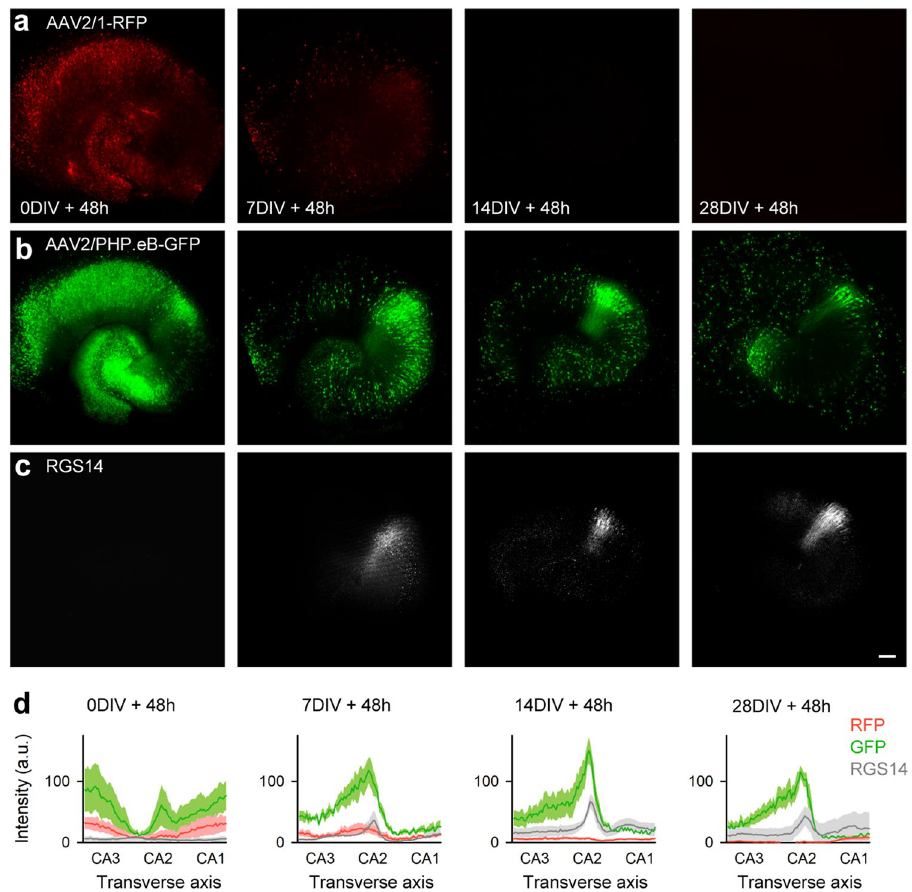
Figure 3. AAV2/PHP.eB vector preference for the CA2 region in ex vivo organotypic slice cultures. ( a ) RFP, ( b ) GFP, and ( c ) RGS14 protein distribution in hippocampal slice cultures. AAV2/1-SynTetOff-mRFP1 and AAV2/ PHP.eB-SynTetOff-EGFP were added to slice cultures at 0, 7, 14, and 28 DIV; RFP/GFP signals and RGS14 immunoreactivity were analyzed 48 h later. Scale bar, 200 μm. ( d ) Signal intensities of RFP (red), GFP (green), and RGS14 (gray) at each time point along the transverse axis of cultured hippocampal slices. Red, green, and gray areas indicate standard errors ( n = 5 slices from 5